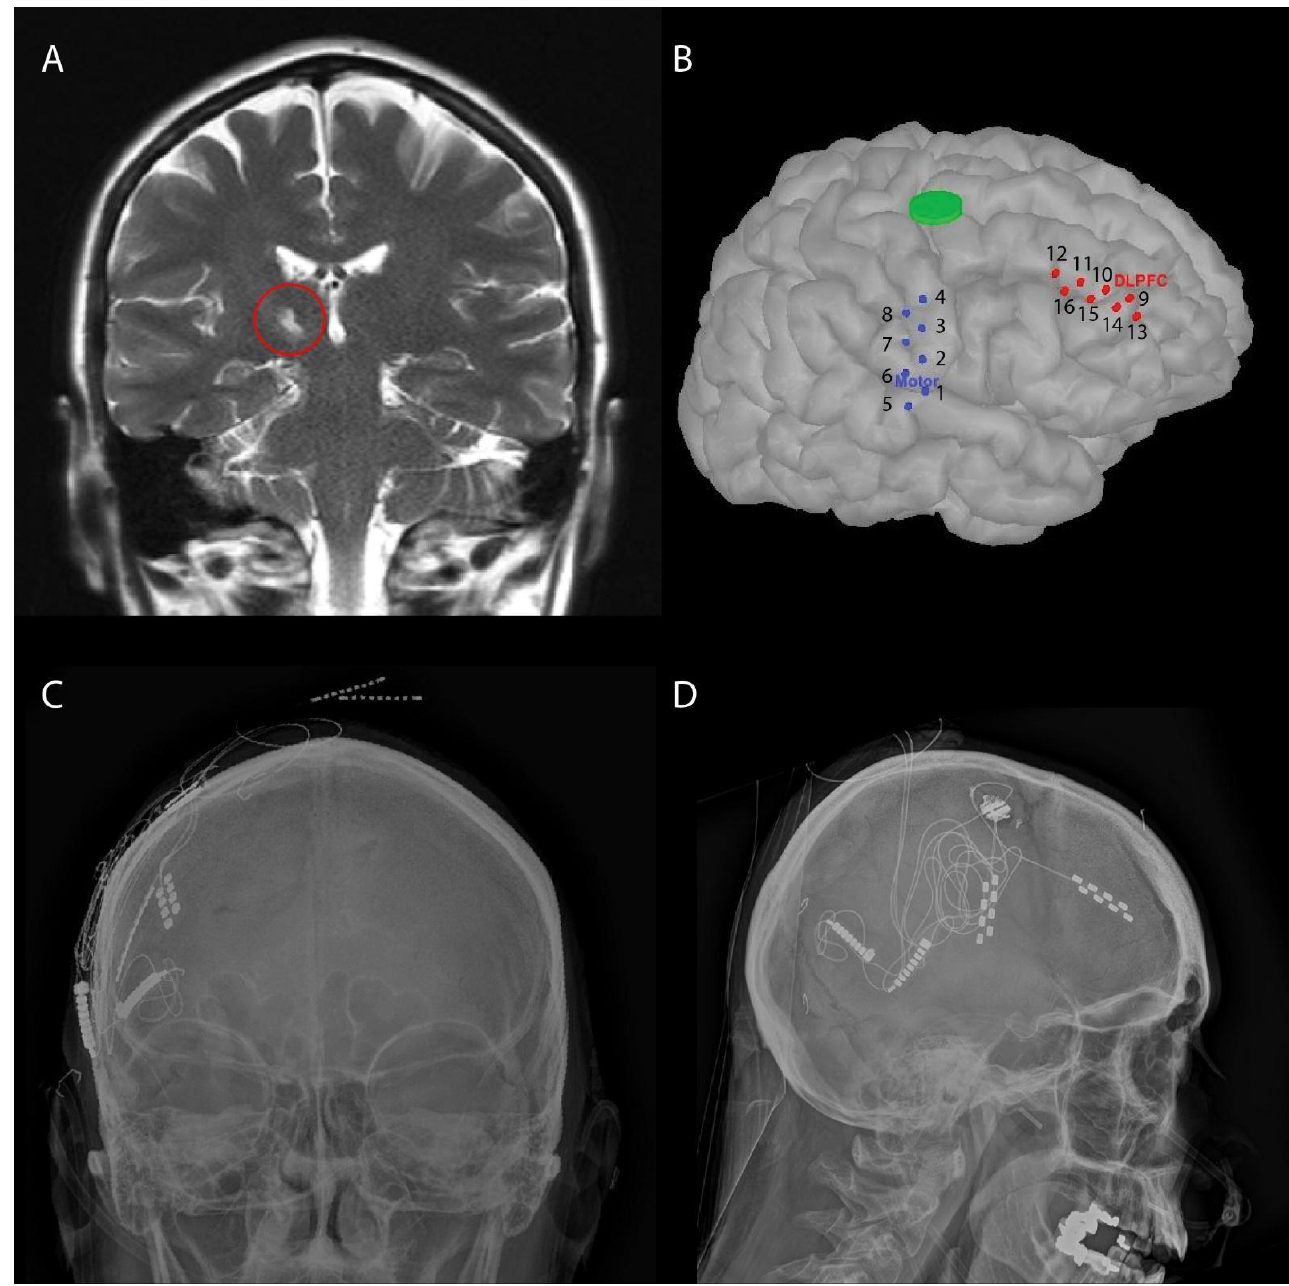
Figure 1. ( A ) T2 MR Coronal section of thalamic infarct (circled in red). ( B ) M1 and dlPFC electrode visualization by co-registration of the patient’s MRI and CT using SPM12 toolbox in Brainstorm [13,14], green circle is the burr hole location. ( C ) Anteroposterior X-ray projection of electrodes. ( D ) Lateral X-ray projection of the two Abbott Lamitrode 44 electrodes implanted on the patient’s right side. with the tunneled extensions seen superior and